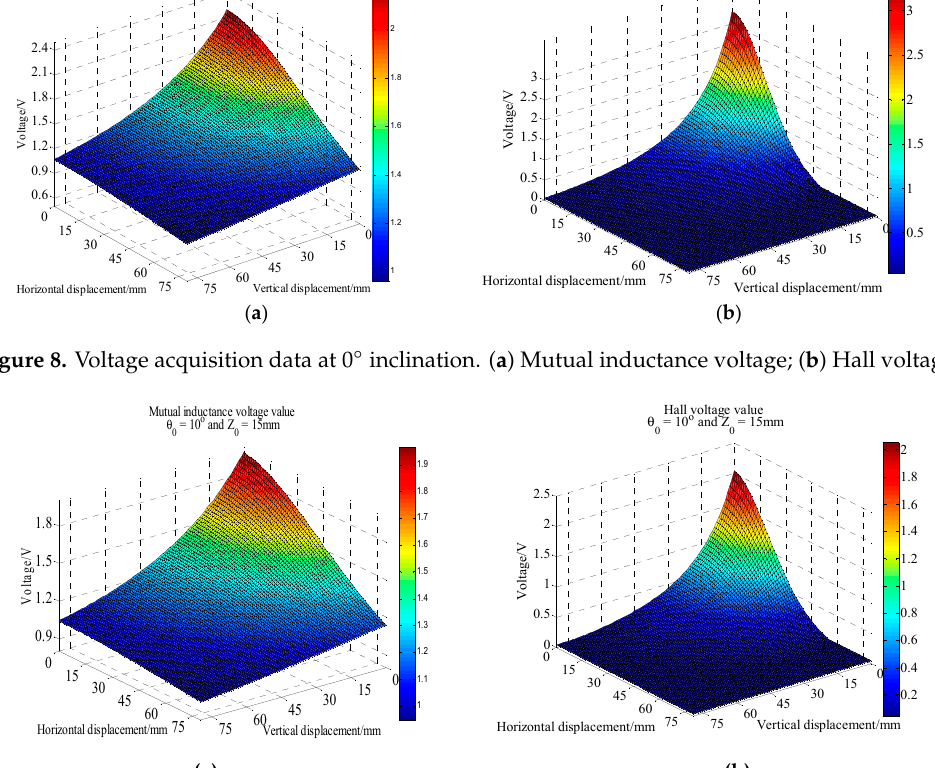
Figure 9. Voltage acquisition data at 10 ◦ inclination. ( a ) Mutual inductance voltage; ( b ) Hall voltage.